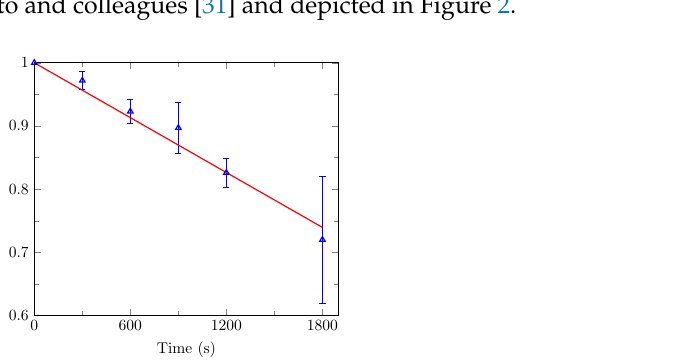
Figure 2. Time-dependent free [ 11 C]MET plasma fraction used for metabolite correction. Population data points represented by blue triangles with error bars (mean ± standard deviation) were obtained by Sato and colleagues from 18 glioma patients [31]. The least-squares fitted linear approximation is plotted in